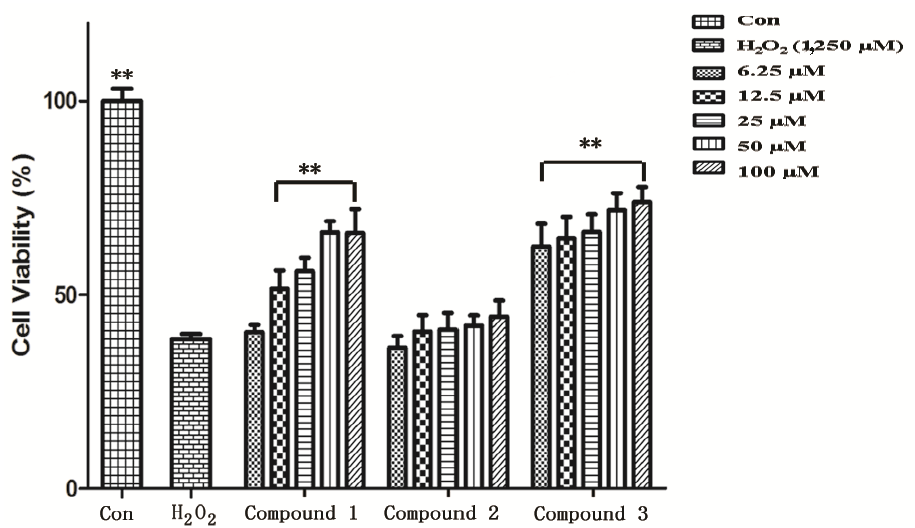
Figure 3. The protective effect of compounds 1 and 2 on H HUVECs. HUVECs were incubated with compounds 1 and 2 at the indicated